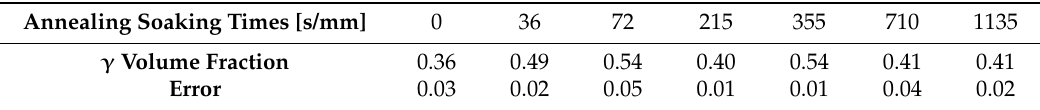
Table 2. γ volume fraction of the γ -austenitic grains during the isothermal annealing at 1353 K (1080 ◦ C).